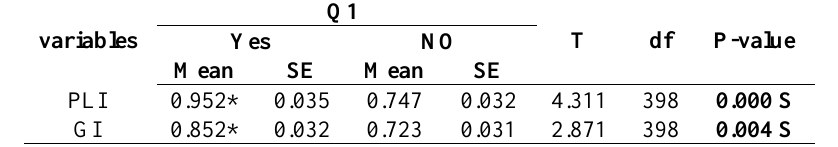
Table (2): Descriptive and statistical test of Plaque index and gingival index among the presence of halitosis.